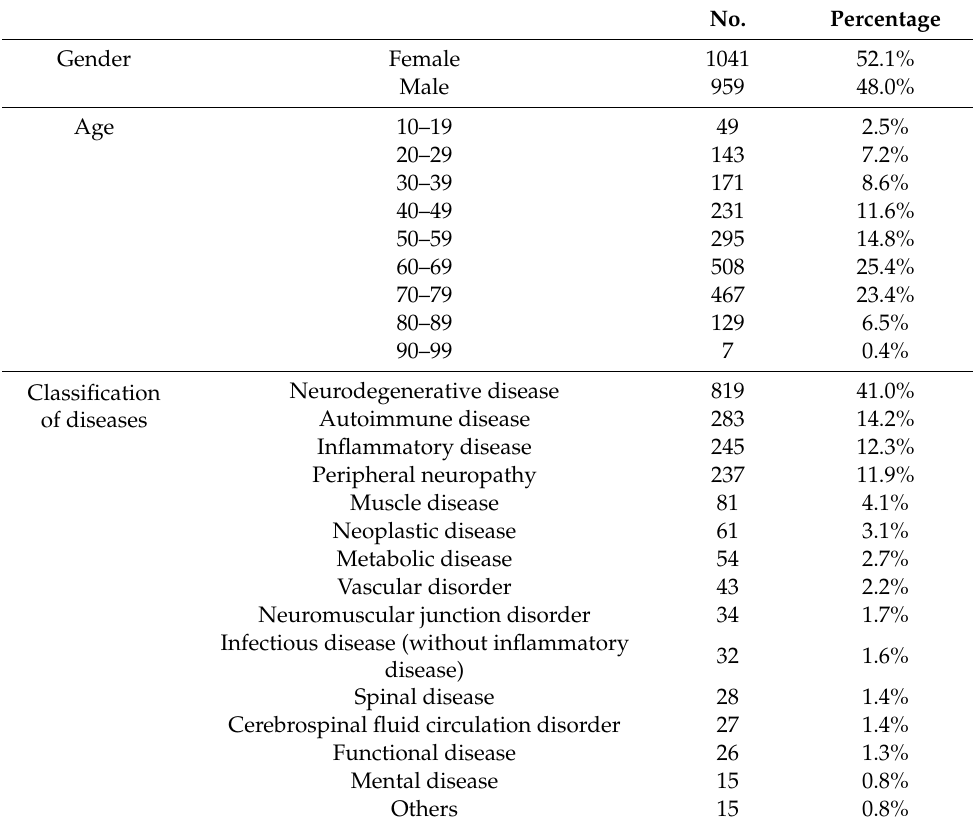
Table 1. Breakdown of information of the